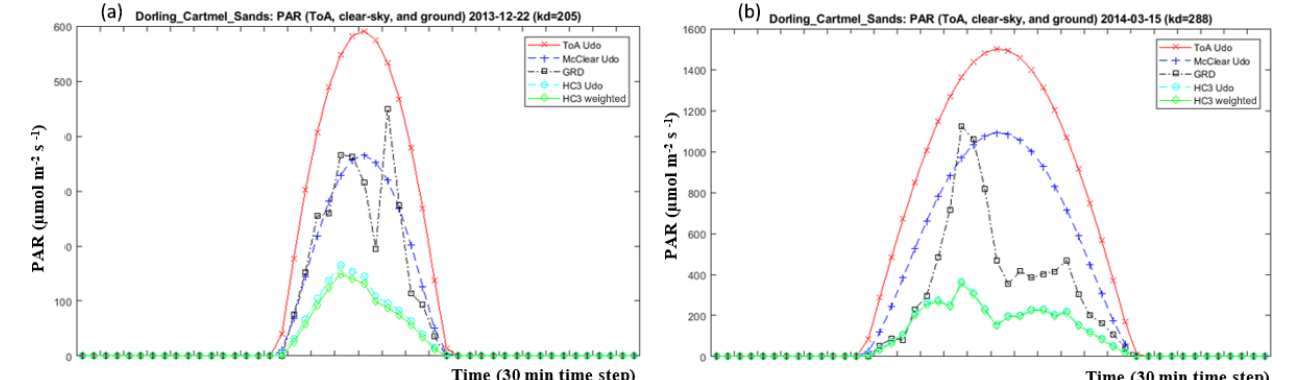
Figure 6. Overestimation of the ground measurements compared to PAR-satellite methods at Cartmel Sands – PAR values (vertical axis) against time (horizontal axis) on respectively 22 December 2013 on (a) , and on 15 March 2014 on (b) . Red line is PAR TOA , blue is PAR in cloud-free conditions, black is ground PAR measurements, and cyan and green lines correspond to 2 PAR-satellite methods: Udo et Aro and Weighted_Kato applied on the SSI